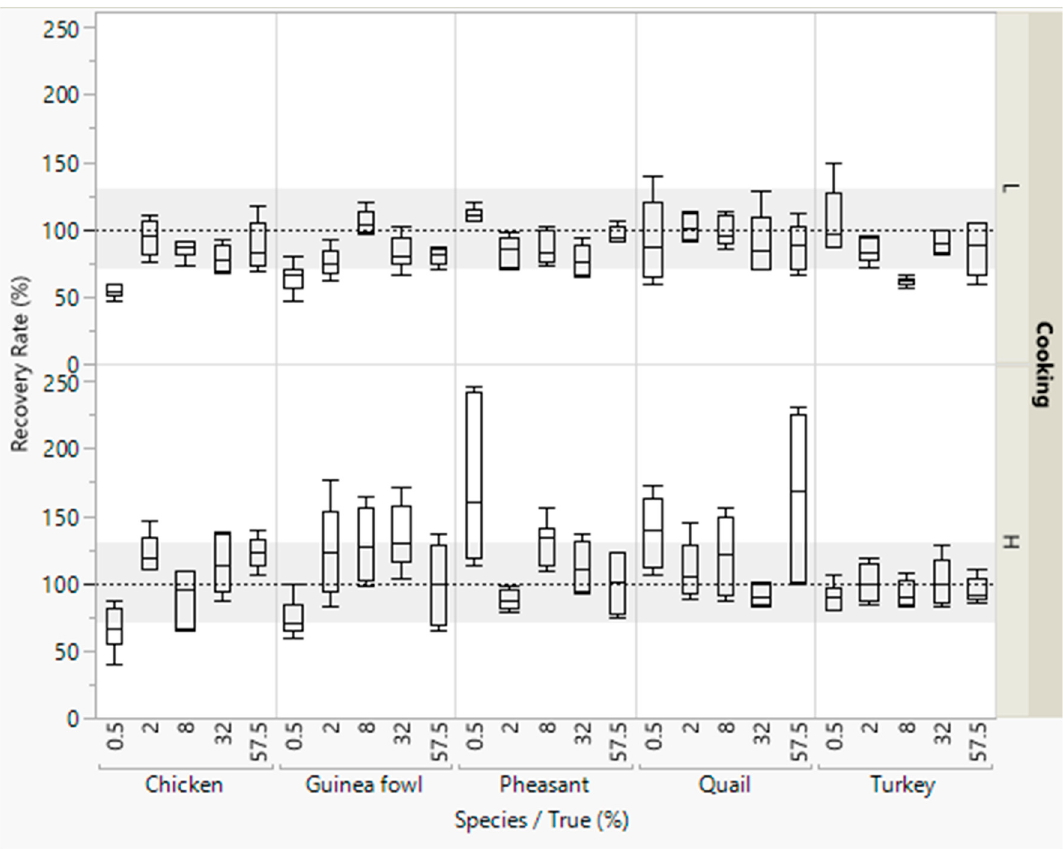
Figure 1. Recovery rates of meat from five poultry species in emulsified type sausages (with 0.5–57.5% meat) quantified with reference material from standard emulsified type sausages (with 0–69% meat). All concentration levels were cooked at low (L) or high temperature (H). DNA was isolated in duplicate from each sausage from both batches, and three independent real-time PCRs were performed, i.e., box plots are from twelve measurements. The grey areas represent the accepted range of 70–130%.